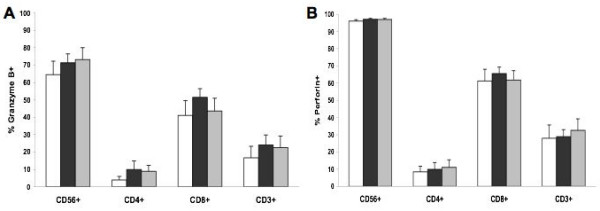
Perforin and granzyme B protein expression by peripheral CD56+, CD3+, CD4+, and CD8+ cells. PBMC were isolated from each subjects. They were first labelled with fluorochrome-conjugated anti-CD56, CD4, CD8, or CD3, permeabilized, then labelled with fluorochrome-conjugated anti- A) granzyme B or B) perforin and analysed by flow cytometry. Columns represent mean ± SEM. Normal non-smokers (white), normal smokers (black), and emphysematous smokers (grey).